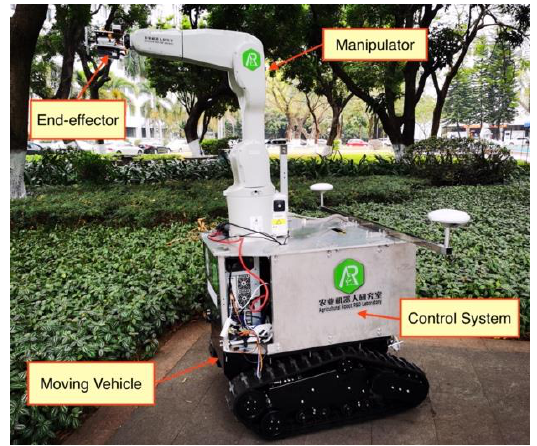
Figure 1. Banana-picking robot.